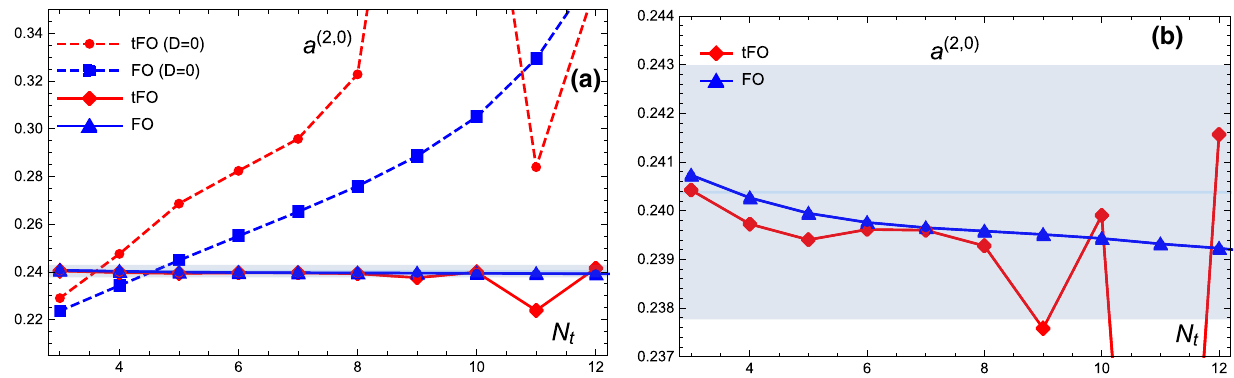
Fig. 8 The results for the moments a ( 2 , 0 ) (σ m ) analogous to those of Fig. 6, but using the results of the global fits of the FOPT (’FO’) and (cid:2) FOPT (’tFO’) approaches instead of the CIPT and PV approaches